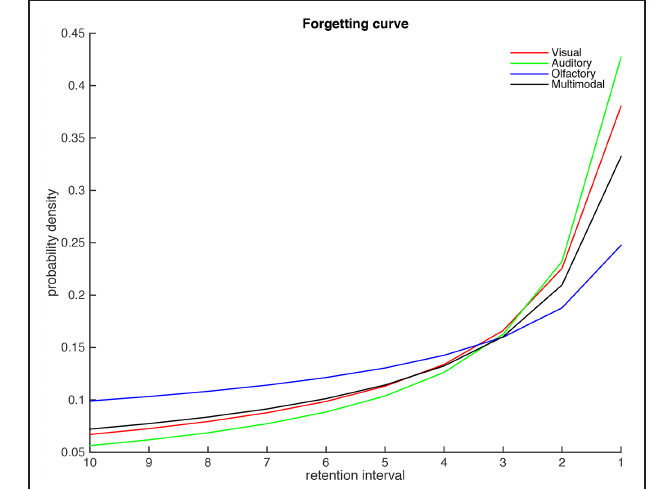
FIGURE 2 | The corrected autobiographical memory distributions for the four conditions.